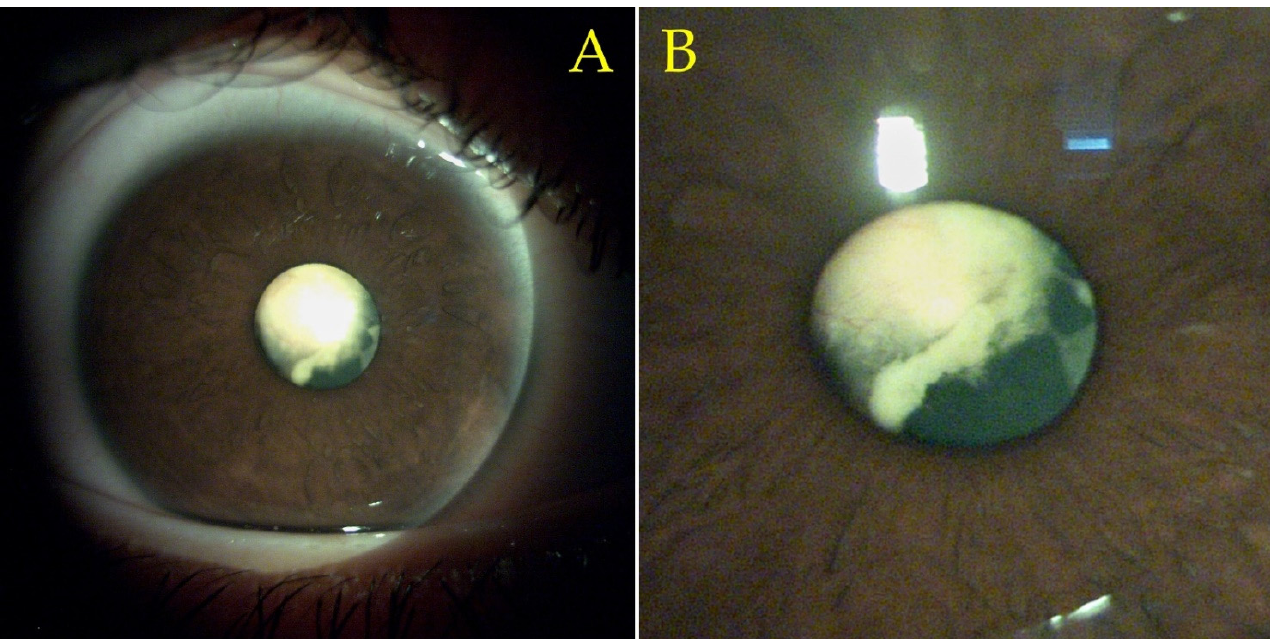
Figure 1. 16x magnification slit-lamp biomicroscopy images of the patient’s right eye. ( A ) Reveals an opaque lens. ( B ) Enhanced (zoomed-in) close-up image that reveals the presence of fine blood vessels located intralenticularly.